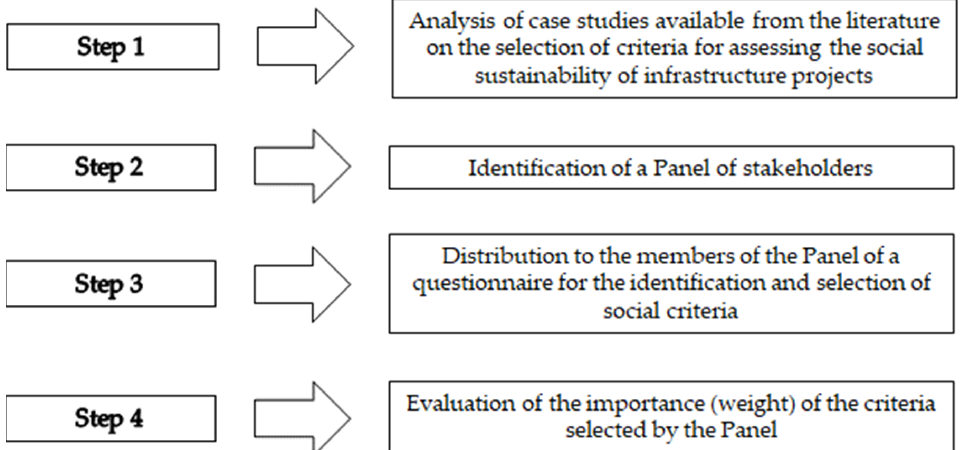
Figure 3. The methodology of the research.